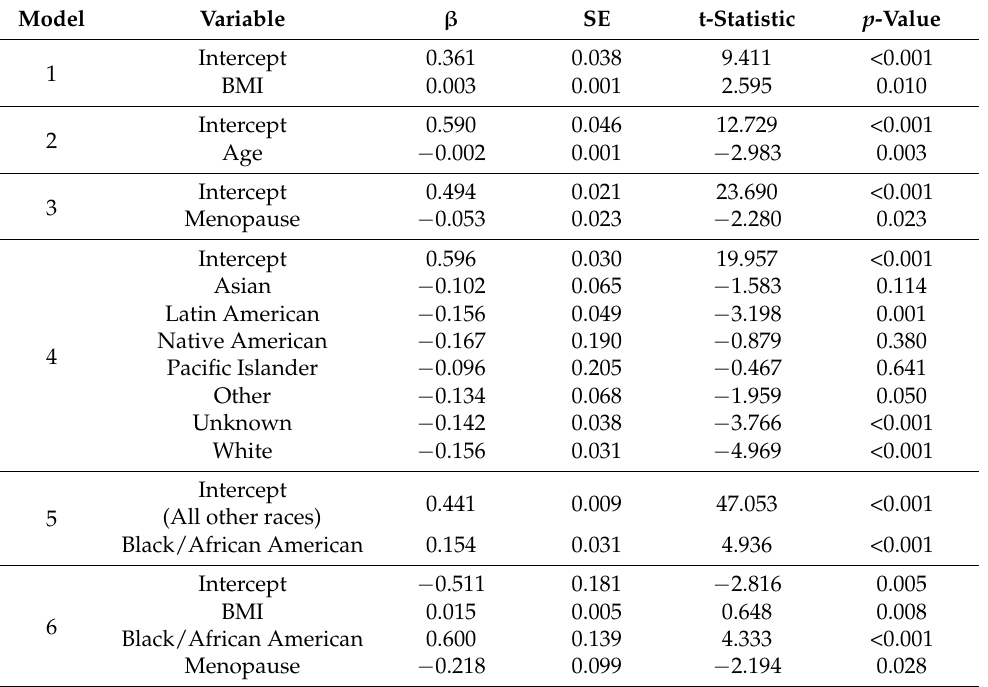
Table 2. Results of univariate and multivariate logistic regression models predicting likelihood of Luminal B breast